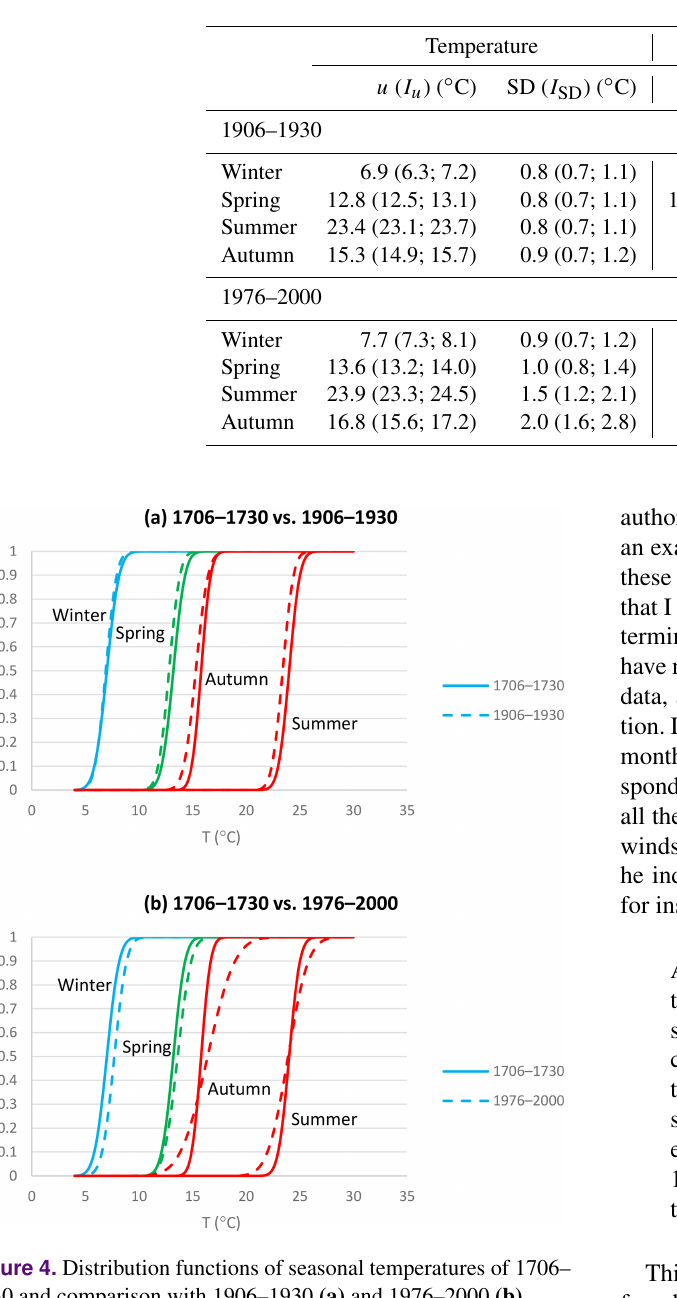
Table 5. Statistics of the periods 1906–1930 and 1976–2000 in Granada. u : mean value; I u : 95% confidence level interval for mean value; SD: standard deviation; I SD : 95% confidence level interval for standard deviation.